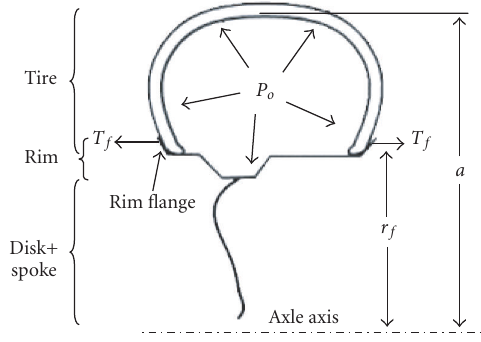
Figure 4: A schematic showing the load induced by tire inner pres-